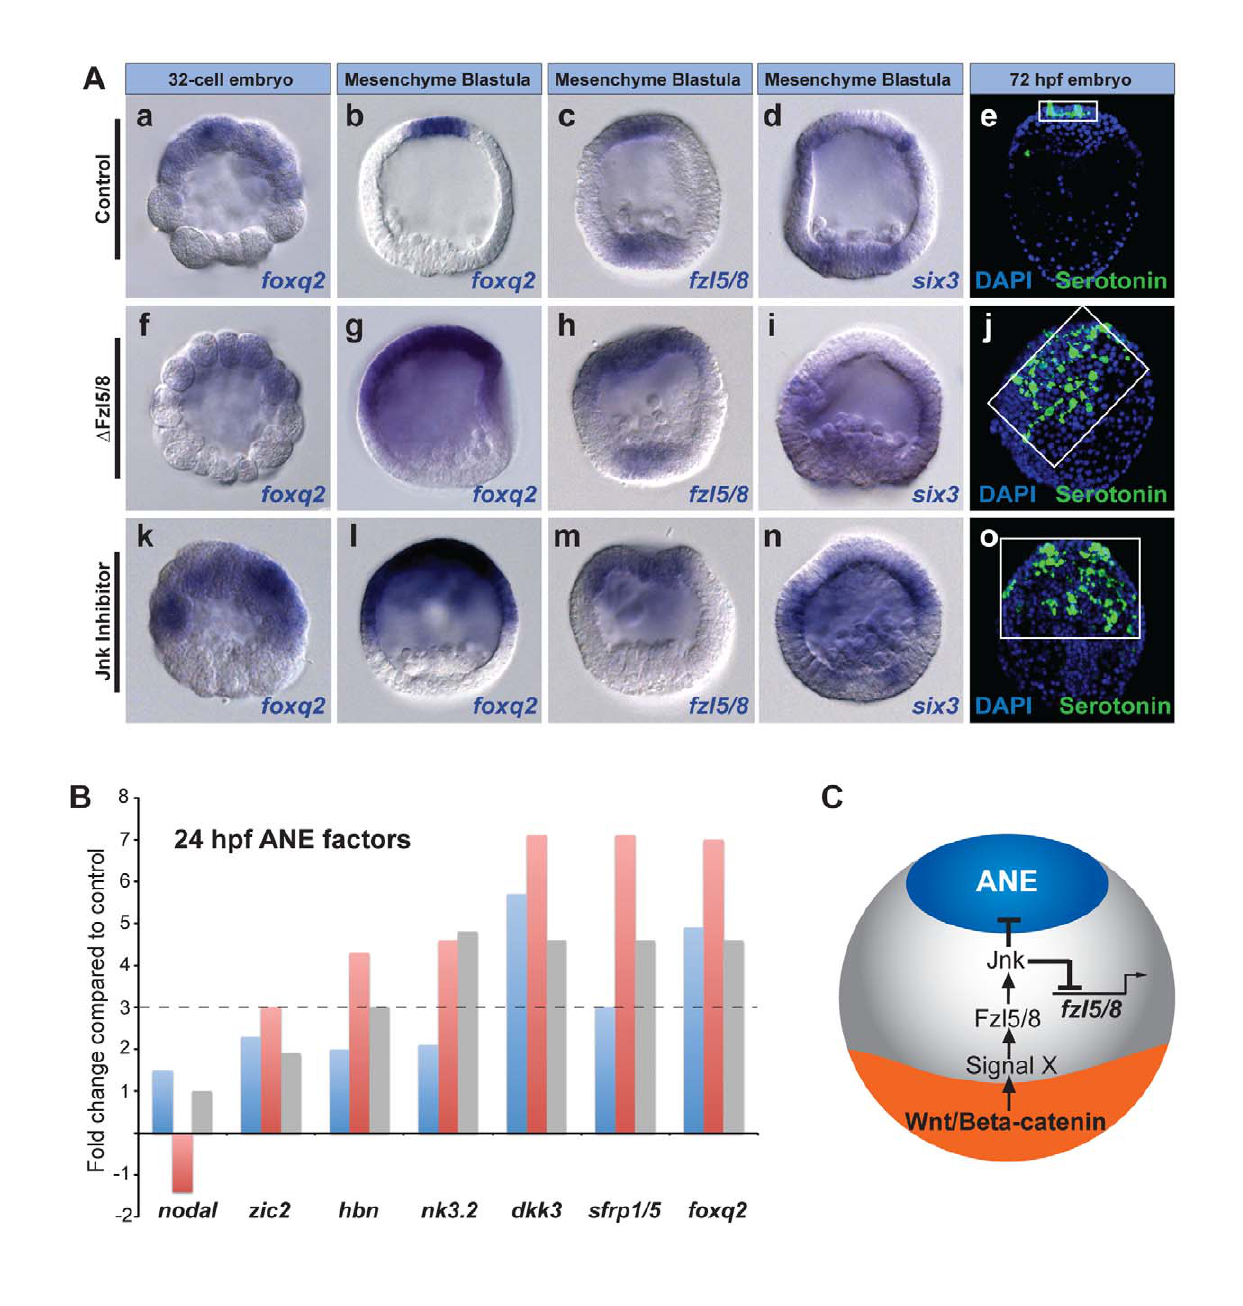
Figure 2. Fzl5/8 signaling and JNK activity are required for ANE restriction. (A) foxq2 , fzl5/8 , and six3 expression in 32-cell and late blastula- stage control embryos (Aa–d), D Fzl5/8 mRNA-injected embryos (Af–i), and embryos treated with JNK inhibitor (Ak–n). (Ae, j, o) Serotonergic neurons in control, D Fzl5/8 mRNA-injected, and JNK inhibitor-treated embryos, respectively. White boxes outline the ANE. Serotonergic neurons (green), DAPI (nuclei, blue). (B) qPCR measurements from three different cultures of embryos showing that ANE regulatory genes are up-regulated at the late blastula stage (24 hpf) in the absence of functional Fzl5/8 signaling. The y -axis shows the fold change in gene expression in D Fzl5/8-containing embryos relative to controls. The dotted line marks a 3-fold change in expression. nodal expression is used as an internal control because it is unaffected in the absence of Fzl5/8 signaling (Croce et al., 2006) [46]. (C) Diagram showing a model for ANE restriction consistent with the data presented in this